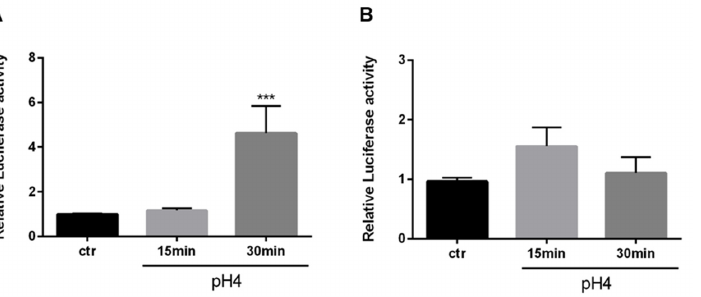
Figure 3 . Acidified medium induces Nrf2 activity in a cell line specific manner. OE33 ( A ) and OE19 ( B ) were treated with acidified medium (pH 4) for 15 and 30 min and were analyzed by luciferase assay. Values are shown as mean ± S.E.M. (Kruskal–Wallis test with Dunn’s multiple comparisons test; ***— p < 0.001, compared to untreated controls).